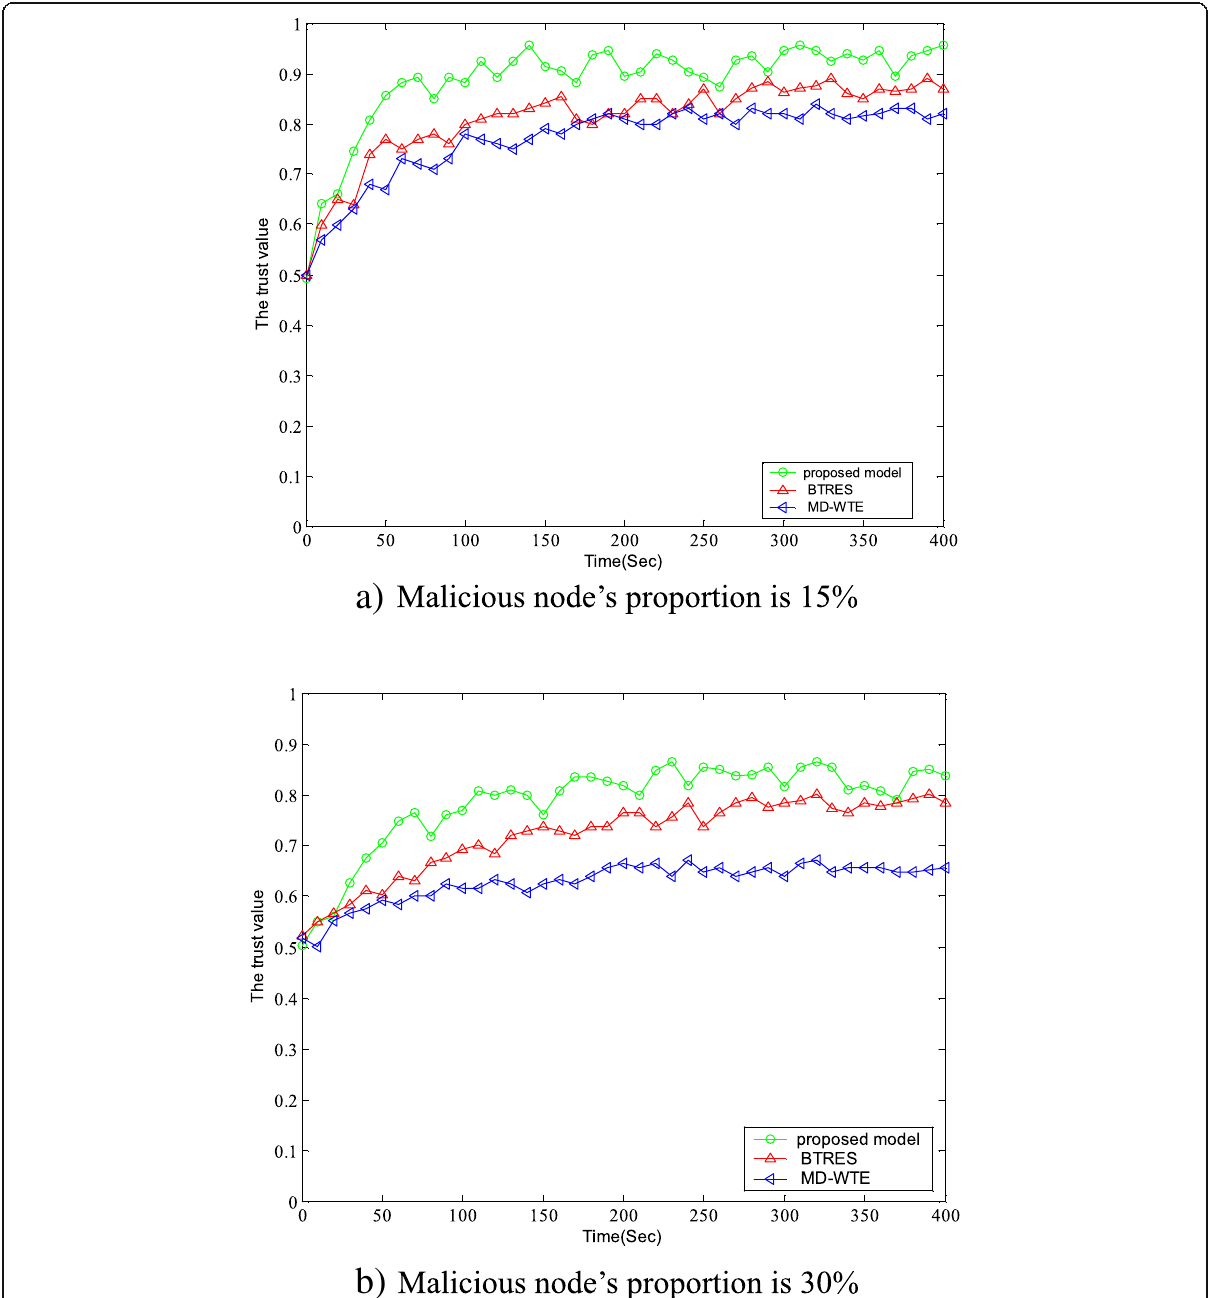
Fig. 1 The trust value of normal node with time. a Malicious node ’ s proportion is 15%. b Malicious node ’ s proportion is